Question: Which visualization type does this figure use?
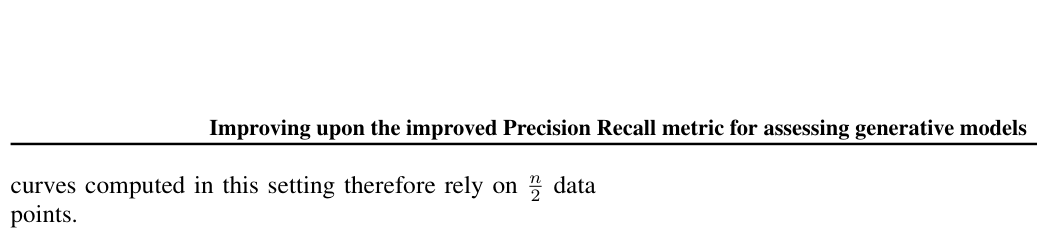
Answer: line